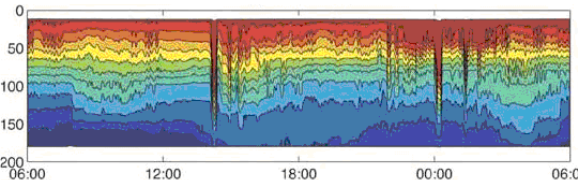
Fig. 9. Time series of internal waves in the South China Sea, from Duda et al. (2004).